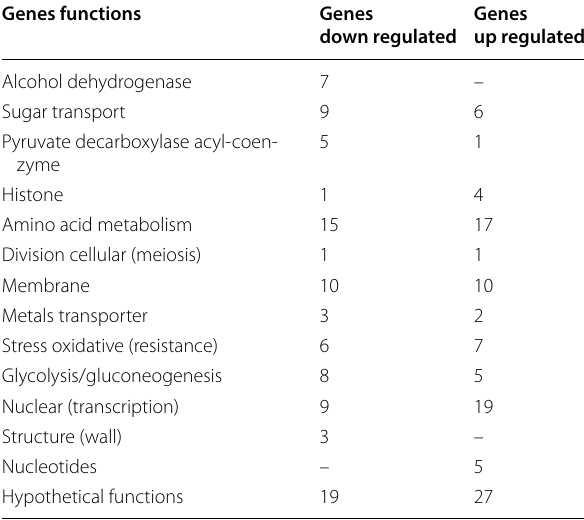
Table 1 Quantification of the reads of the RNA-Seq (Illumina) sequencing and mapping of time 0 h and 8 h of samples of contaminant yeast, C. tropicalis